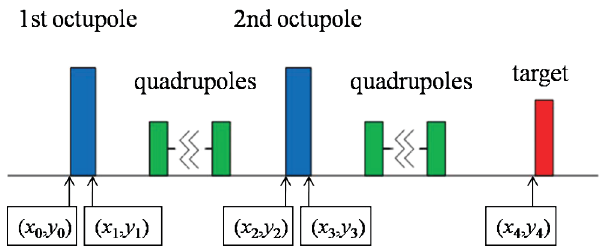
FIG. 1. A schematic plot of the transport system in the trans- ( i ¼ 0 ; 1 ; 2 ; 3 ; 4 ) stands for the displacement at port line. x i different